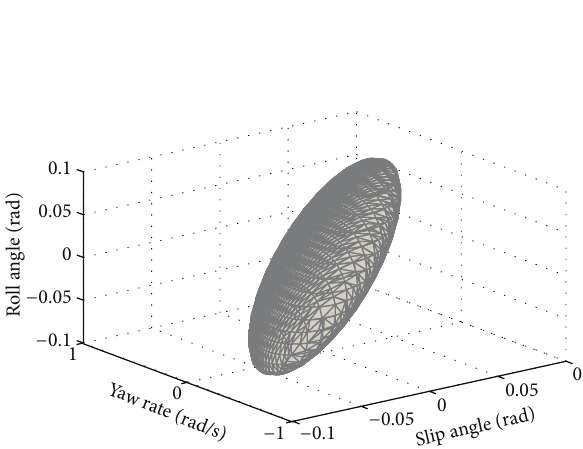
Figure 9: Comparing the stability region to vehicle tests